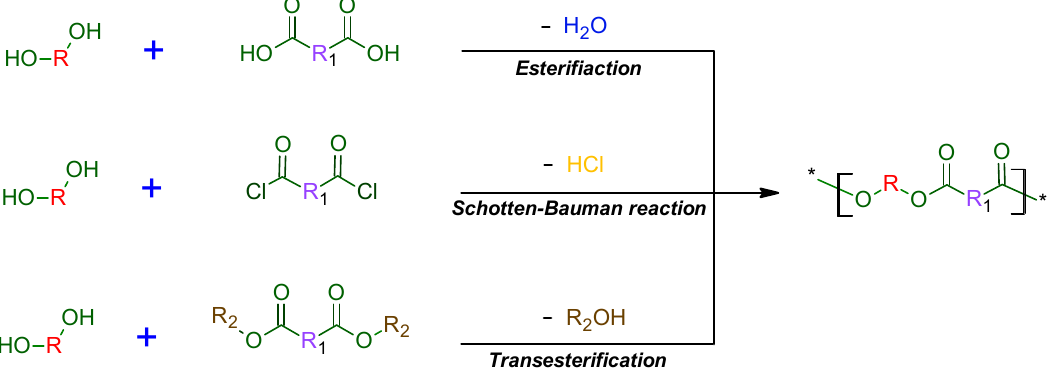
Figure 2. Examples of stepwise polycondensation reactions for the preparation of polyesters